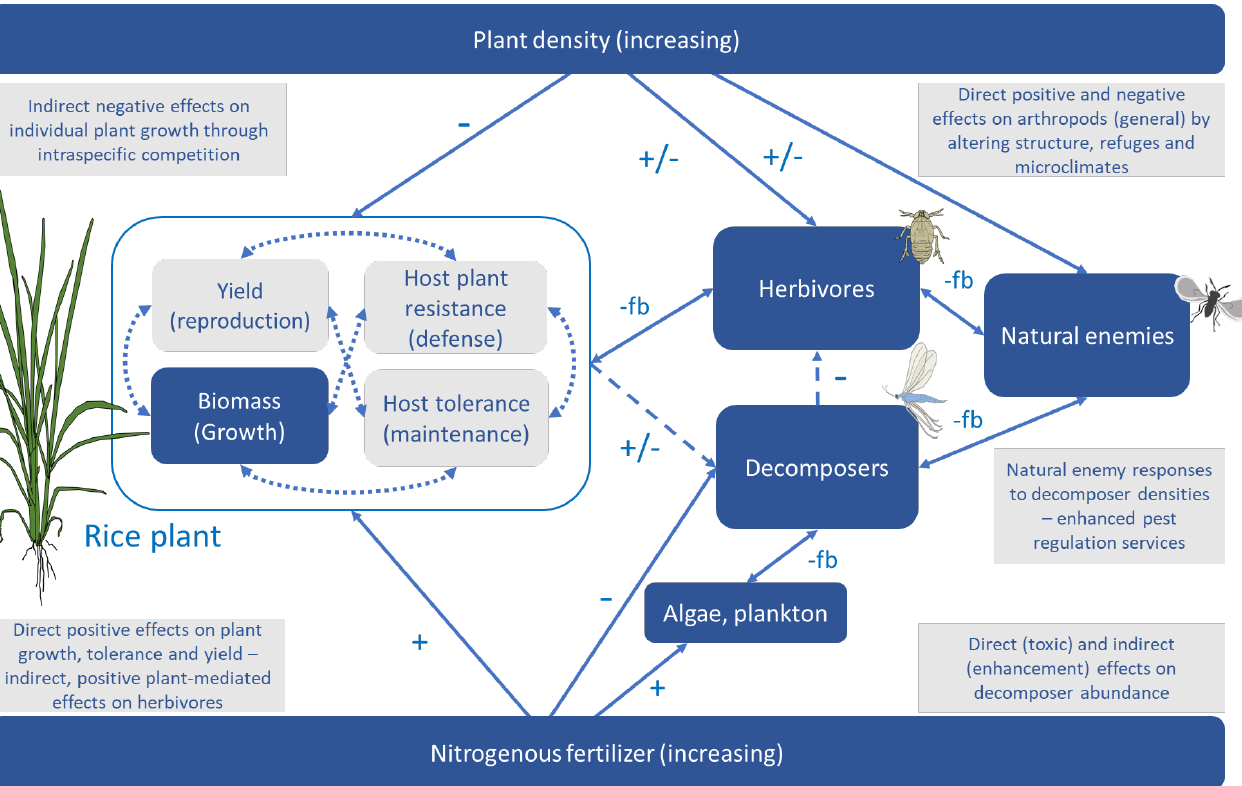
Figure 10. Schematic representation of some of the main interactions of planting density, nitrogenous fertilizer, and host plant resistance with arthropod communities in tropical rice. Interactions are indicated as mainly positive (+), mainly negative ( − ), conditionally positive or negative (+/ − ; depending on arthropod species or levels of exposure), and part of a negative-feedback, regulatory mechanism ( − fb). Lines indicate prominent directions of energy flow: solid arrows are direct effects, dashed arrows are indirect effects, and dotted arrows (within the rice plant) are trade-offs. Based on the results of the present study, nitrogenous fertilizer increases rice plant growth and can positively impact decomposer abundance (e.g., indirectly through increases in algal and plankton growth). Enhanced rice plant growth increases yields and tolerance against herbivores, but increases rice susceptibility to herbivores. Nevertheless, resistance against the brown planthopper is required if fertilizers are to increase tolerance to this pest. Increasing plant density decreases individual plant growth, potentially reducing tolerance and susceptibility to herbivores. High-density rice stands provide structural habitat for arthropods in general, but can negatively impact some arthropods (i.e., egg parasitoids in this study). High decomposer abundance in response to applied nitrogen increases natural enemy abundance through numerical and reproductive responses, thereby increasing herbivore vulnerability to generalist parasitoids and